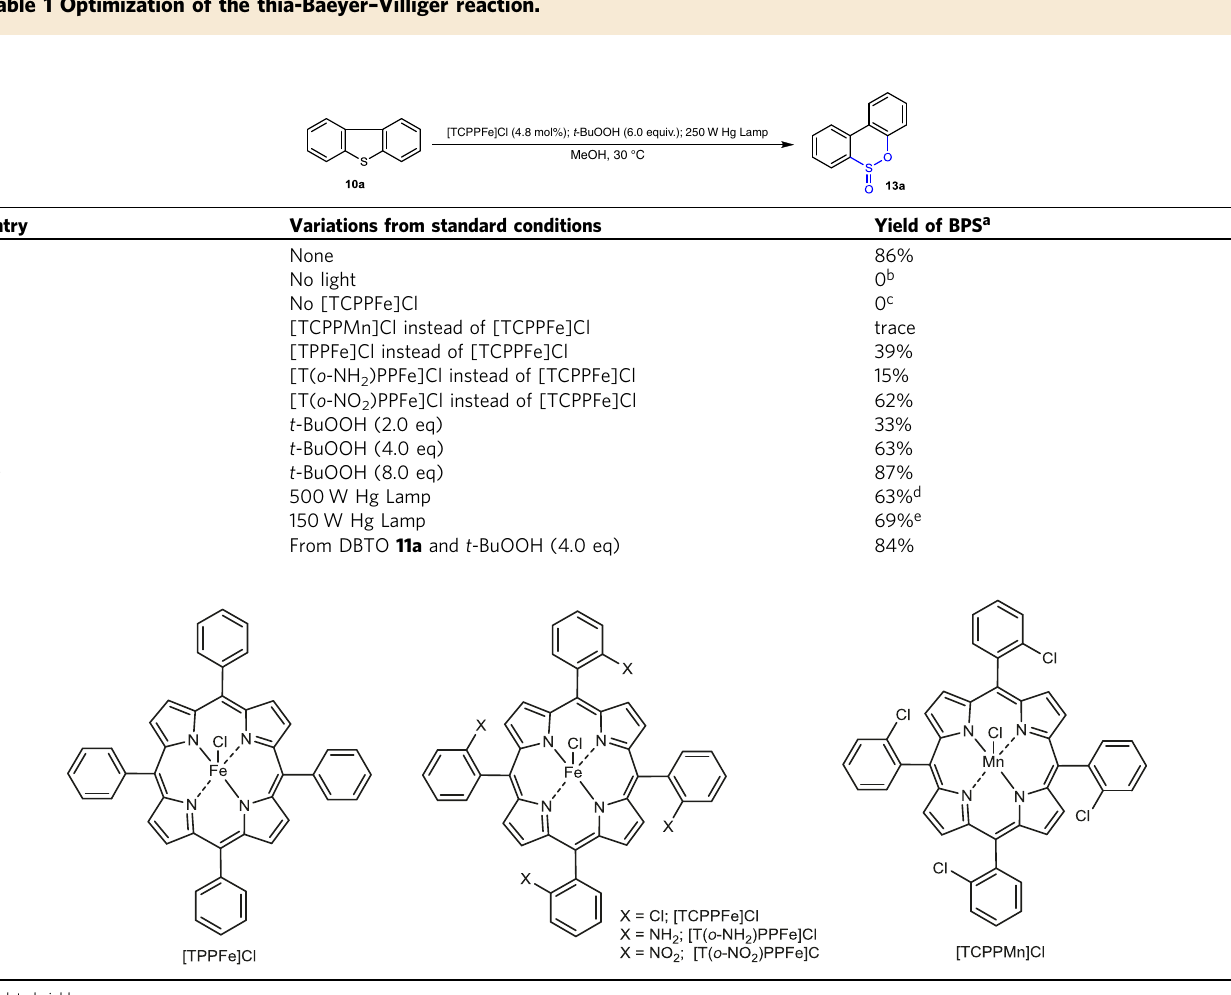
Table 1 Optimization of the thia-Baeyer – Villiger